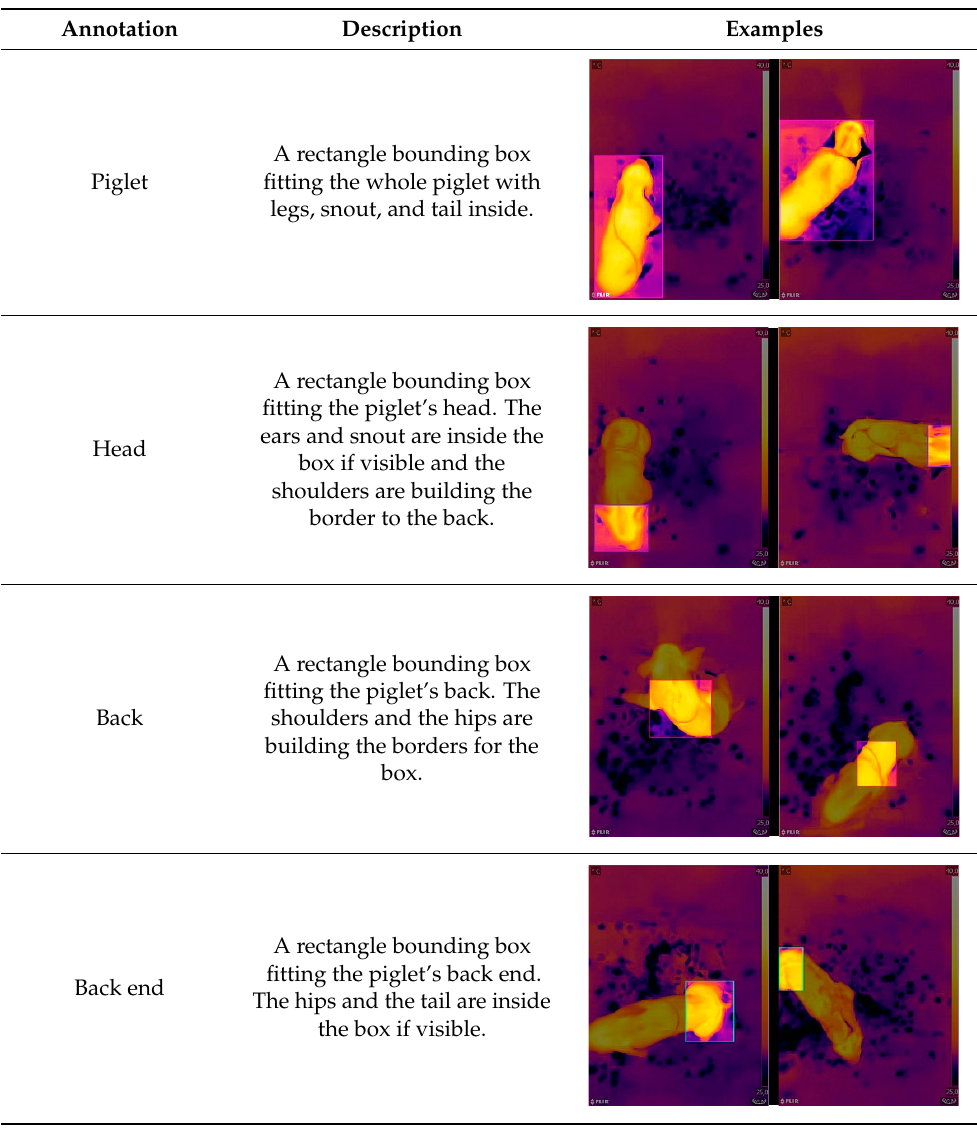
Figure 2. Example Otsu algorithm for the head of a piglet: ( a ) shows the four bounding box detec- tions of YOLOv3-SPP; ( b ) is an image of the area “piglet” after gray value conversion (0–255); ( c ) shows a binary image of the piglet, after thresholding with Otsu algorithm on image ( b ). Image ( d ) shows the overlap of the white foreground area ( c ) and the detected “head bounding box area” from ( a ). The pixels inside the red area are used for further calculations of the head. 2.4. Implementation The complete workflow (Figure 3) is implemented in the R package “ThermalPigR” [24] using Python 3.8 besides R. The package has several integrated functions which perform the following functions: